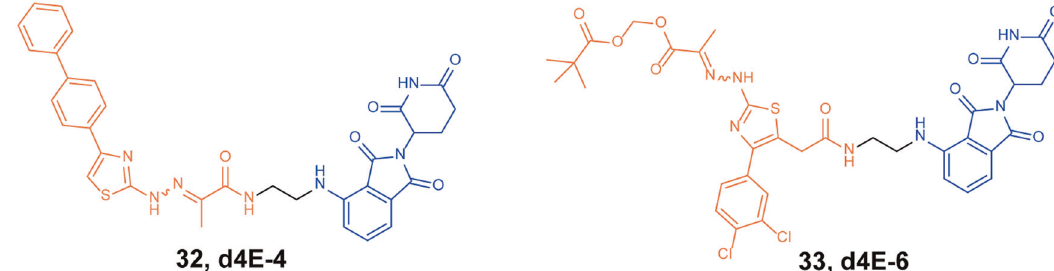
Fig. 8 The representative PROTACs targeting